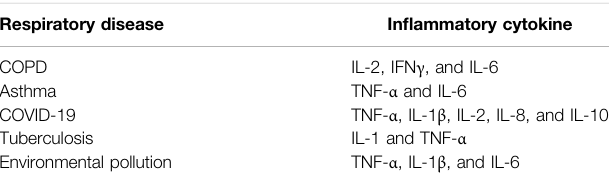
TABLE 1 | In fl ammatory cytokines related to osteoporosis in different respiratory diseases. Respiratory disease